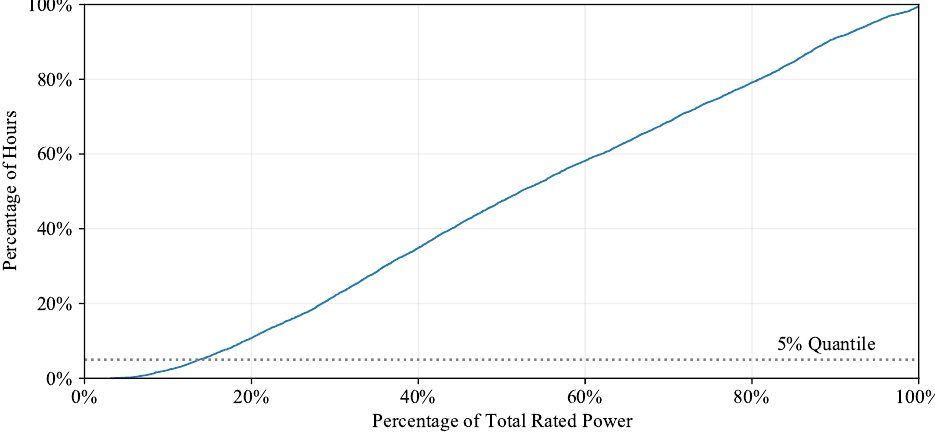
Figure 11. Cumulative distribution function of total power generation in percent and corresponding 5% quantile in 2019. Note that the CDF starts with a zero slope at the beginning, illustrating that there are no hours without power